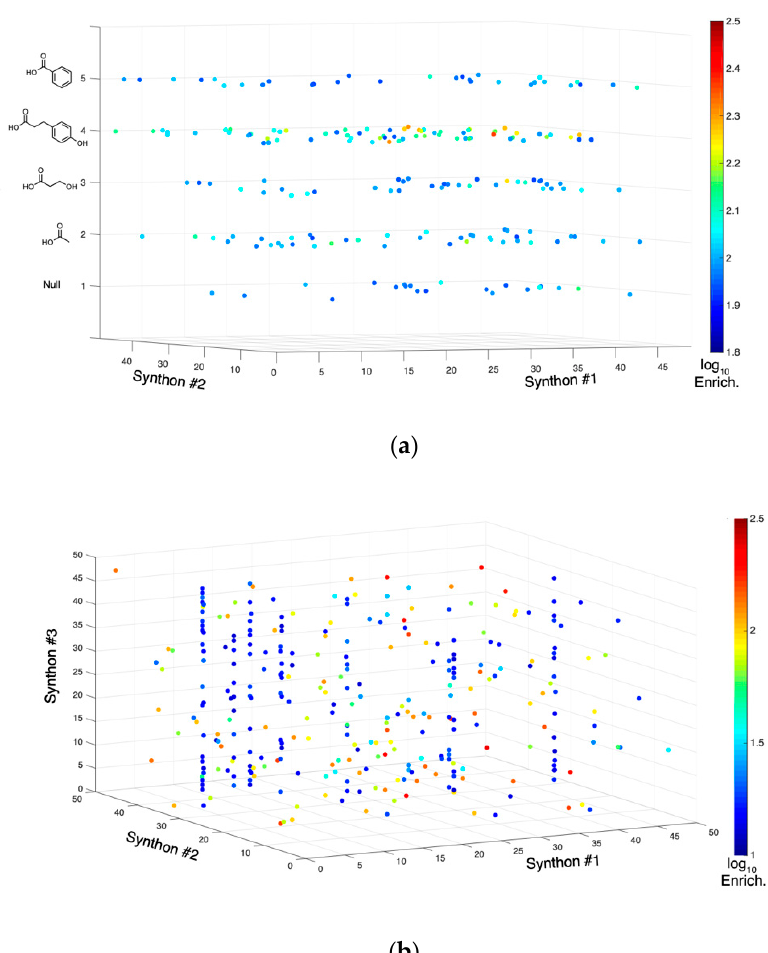
Figure 2. Cubic plot analysis of DNA-encoded chemical libraries (DEL) selection. ( a ) The highest 200 enriching members of the library encoded by the initial 48 codons (A library) are plotted indicating the synthon numbers of the first ( x -axis), second ( y -axis), and fourth ( z -axis) chemical steps. ( b ) The highest 300 enriching members of the library encoded by the initial 48 codons (A library) that contained the phenol cap in the fourth step are plotted indicating the synthon numbers of the first ( x -axis), second ( y -axis), and third ( z -axis) chemical steps. Color of the points corresponds to the log 10 of the enrichment relative to the unselected library as indicated in the color bar scale.